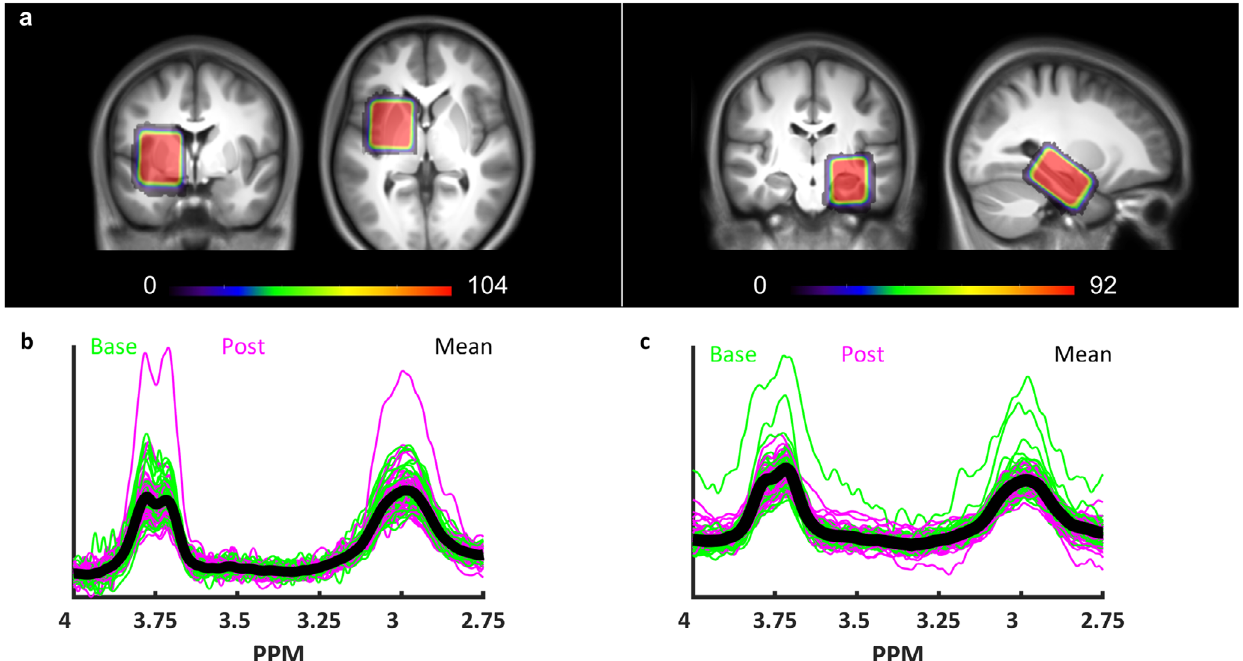
Fig. 3 MRS. a Heatmaps representing the spatial overlap across participants and time points (baseline and post) for the STR (left panel) and HC (right panel) MRS voxels (STR: N = 104 voxels; HC: N = 92 voxels). Colour bars represent the number of overlapping voxels. Heatmaps are overlaid over the mean structural image across all participants (STR: N = 52 subjects; HC: N = 46 subjects). The high degree of spatial overlap indicates that there was a high consistency in voxel placement across time points and individuals for both voxels. b Spectra of all STR MRS measurements and c HC measurements from all participants and time points. GABA + peak is visible at 3 p.p.m. Baseline and post intervention/learning time points are depicted in green and magenta, respectively (mean spectrum across all participants and time points depicted in black). It is noteworthy that although there are extreme peaks, none of the extracted GABA + levels were statistical outliers. Base, baseline pre-intervention/learning. Post, post